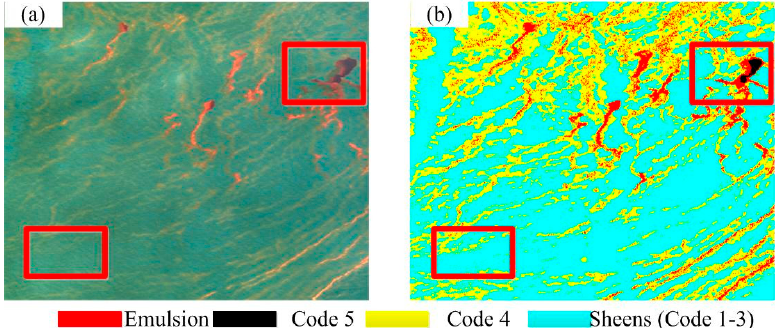
Figure 14. Photo ( a ) is the original training image, and picture ( b ) is the identification result. In the results, red pixels represent identified emulsions, black pixels are oil slicks of code 5, yellow pixels are oil slicks of code 4, and cyan pixels are